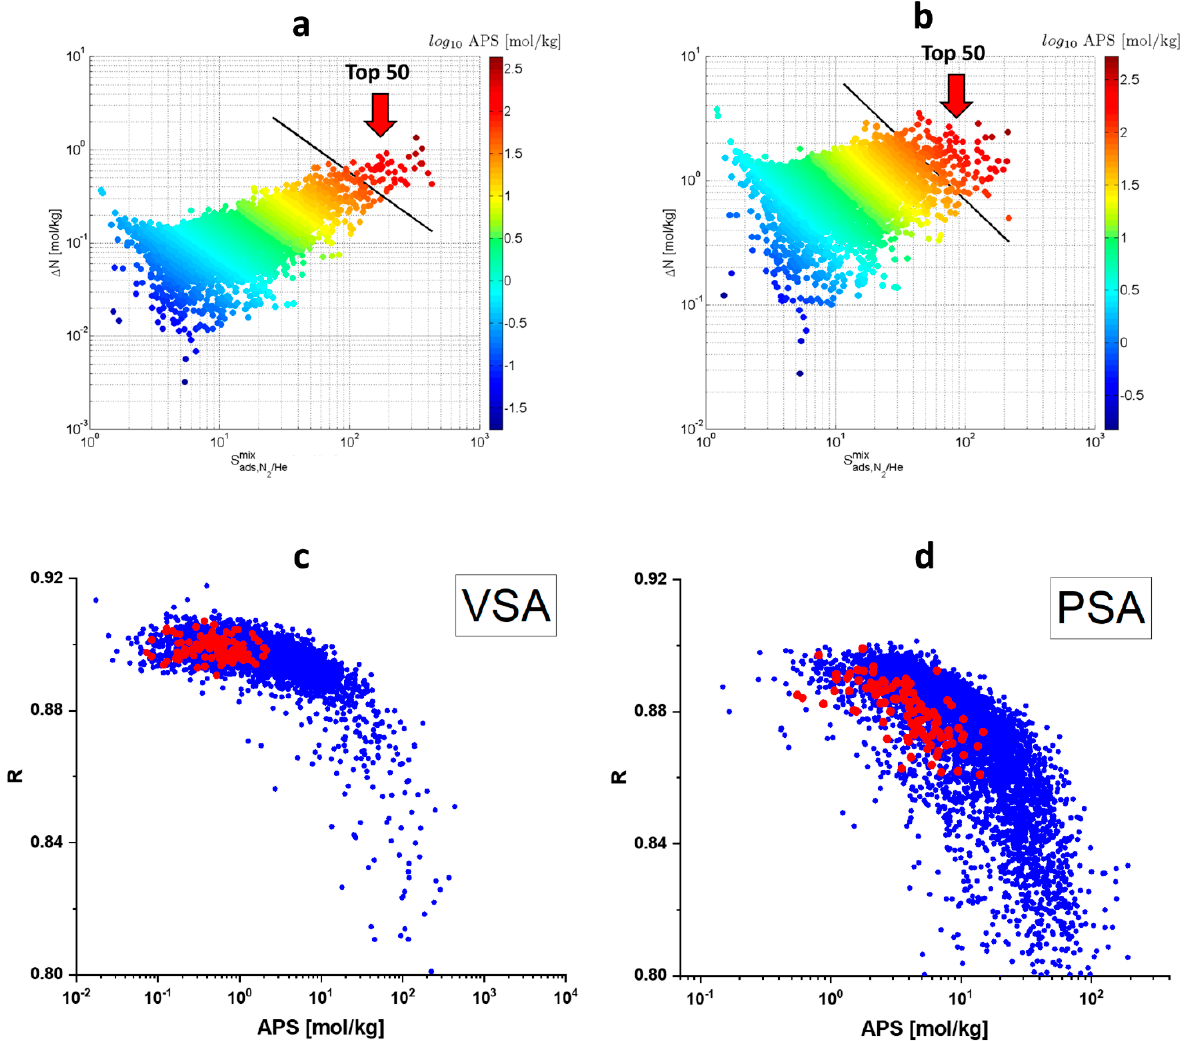
Δ mix S ) and ) and APS ) on adsorption selectivity ( ads , N 2 / He ads N He 2 , /